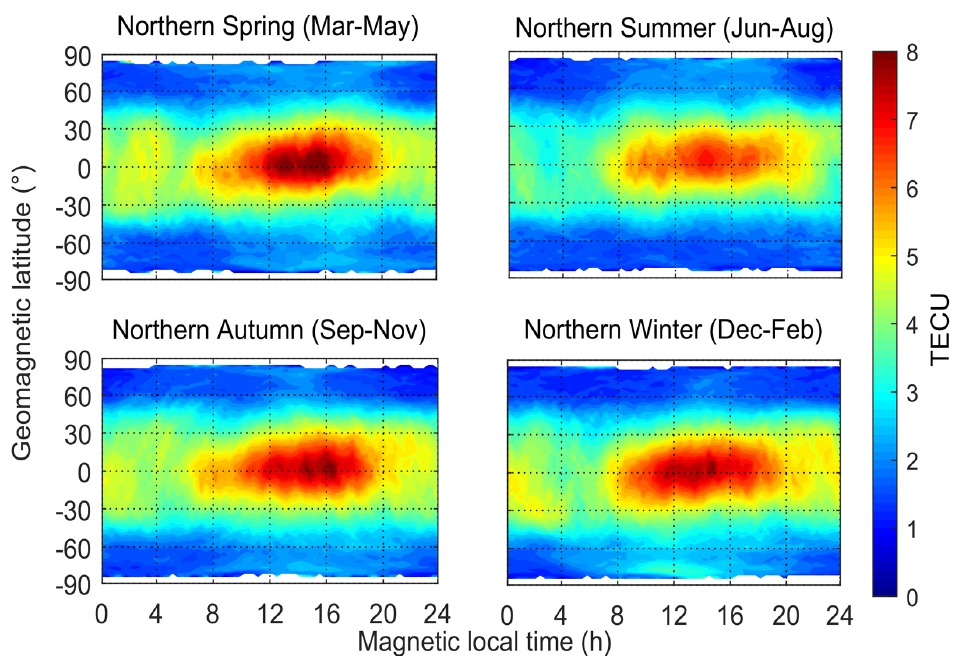
Figure 6. Seasonal variation of plasmaspheric TEC in 2008. In the high PTEC value belts within ±45° geomagnetic latitude, the peak values of PTEC in monthly and seasonal models all appear in the geomagnetic equatorial region To analyze the influence of magnetic local time and geomagnetic latitude on plas- maspheric TEC, we divided the monthly PTEC into six parts. There are daytime and nighttime regions: the magnetic local time from 6:00 to 18:00 o’clock is the daytime, and the nighttime is from 18:00 to the second day’s 6:00 o’clock. As for geomagnetic latitude,